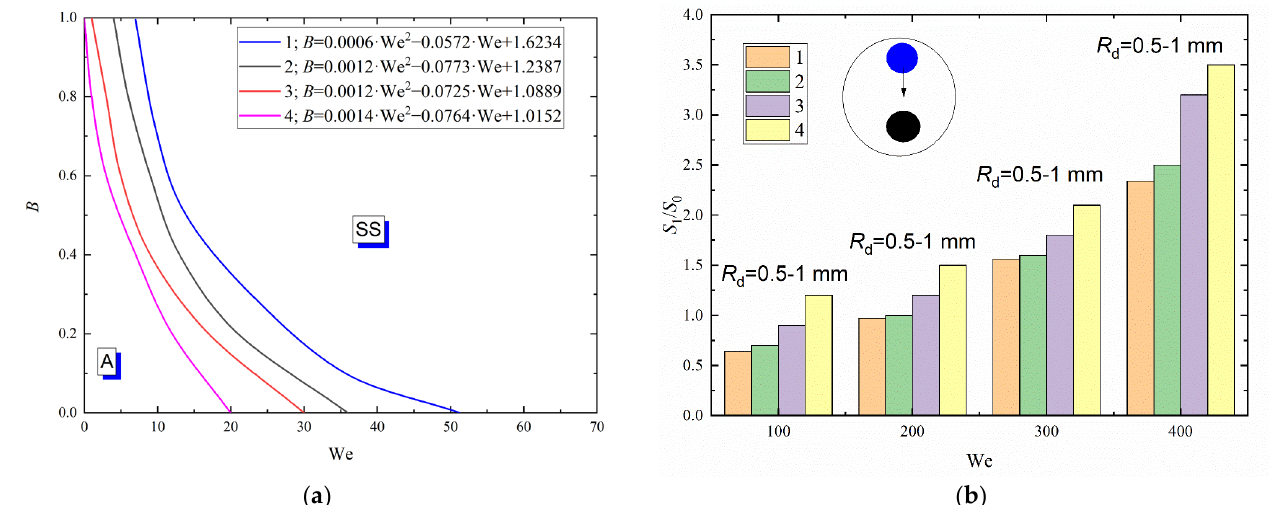
Figure 9. Collision regime maps for liquid droplets interacting with solid particles ( a ) and ratios of free surface areas after (S 1 ) and before (S 0 ) the head-on collision with B = 0 ( b ) at varying interfacial tensions of liquid: 1—distilled water; 2—90 vol% diesel and 10 vol% water; 3—90 vol% diesel, 10 vol% water and 0.08 g/L emulsifier D c D; 4—90 vol% diesel, 10 vol% water, and 1.6 g/L emulsifier D c D.